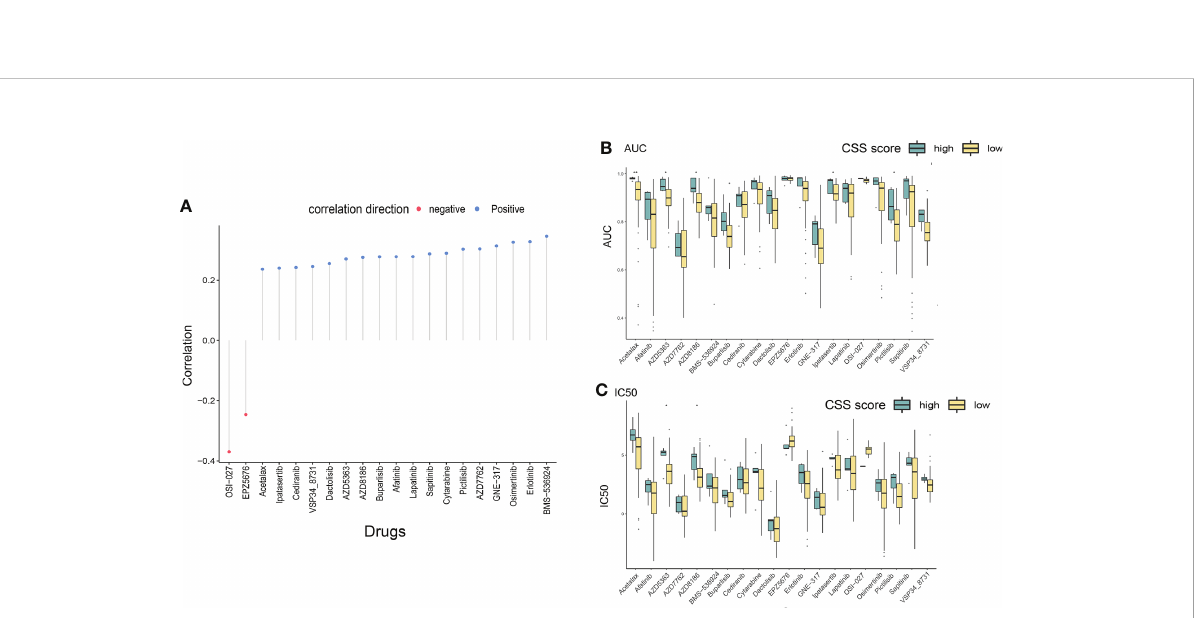
FIGURE 10 Drug susceptibility analysis of different CSS subgroups. (A) The correlation between CSS value and IC50/AUC of different chemotherapeutic and targeted drugs through Spearman ’ s method. (B, C) The differences in drug sensitivity (IC50/AUC) between high and low CSS groups were compared. *P<0.05, **P<0.01. IC50, 50% inhibiting concentrations; AUC, area under the curve; CSS, cuproptosis scoring